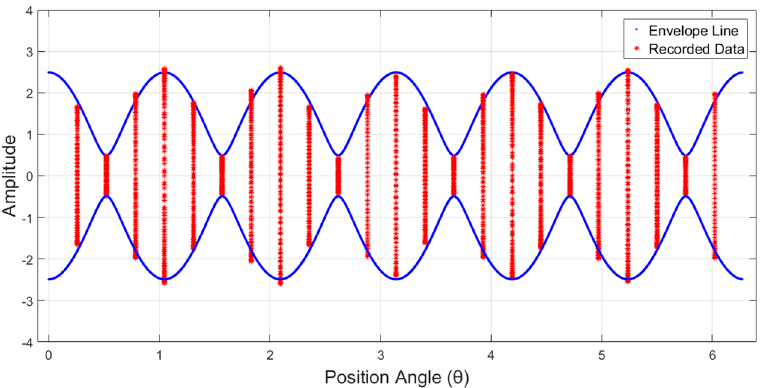
Figure 8. Amplitude variation range of 23 measurement coils with the theoretical envelope line.